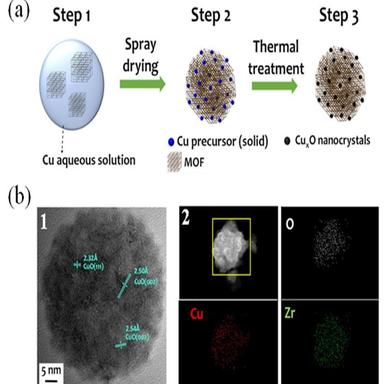
(a) Synthesis of CuxO@MOF hybrid nanostructures using the gas-phase EISA. (b) Microscopic analysis of CuxO@UiO-66 after EISA. T = 400 C. 1: HRTEM image analysis of CuxO@UiO-66. 2: SEM image with the elemental mapping of CuxO@UiO-66. Reprinted with permission from Ref..